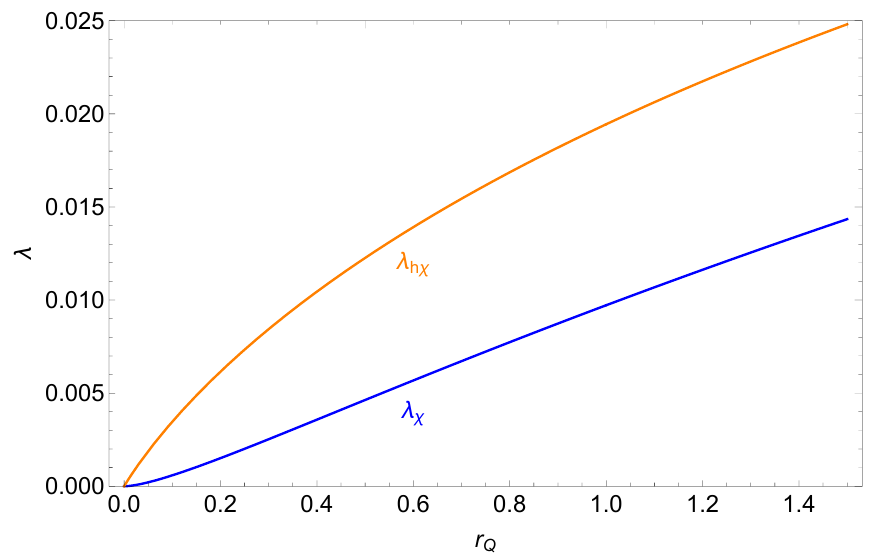
. We have =m 2 V Q